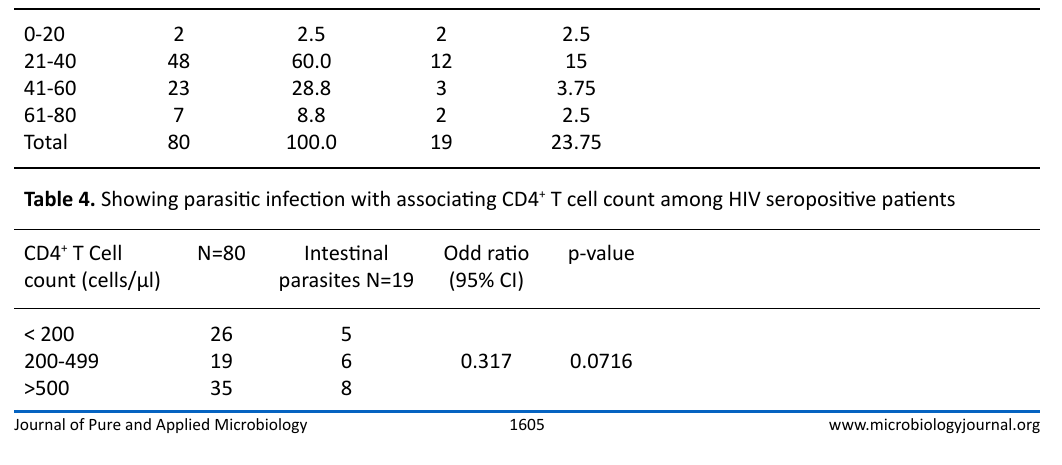
Table 3. Distributions of HIV seropositive patients with positivity according to age Age Number of Percentage Number of Percentage patient positive 0-20